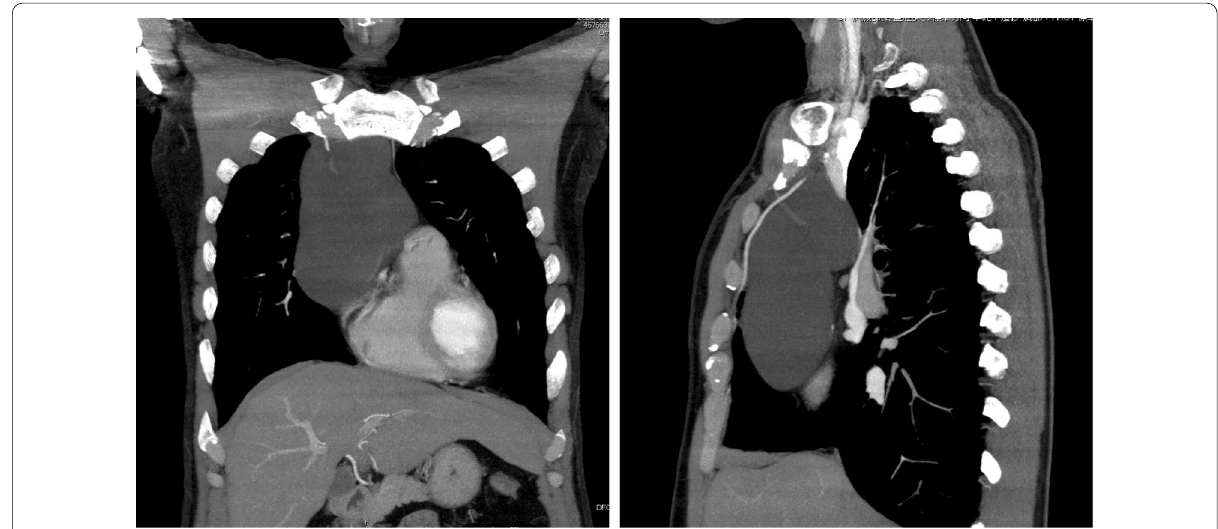
Fig. 2 Enhanced CT revealed a lobulated homogenous giant mass in the superior-to-anterior mediastinum. The components of the cyst had increased CT attenuation of 10 HU, which is higher than that of